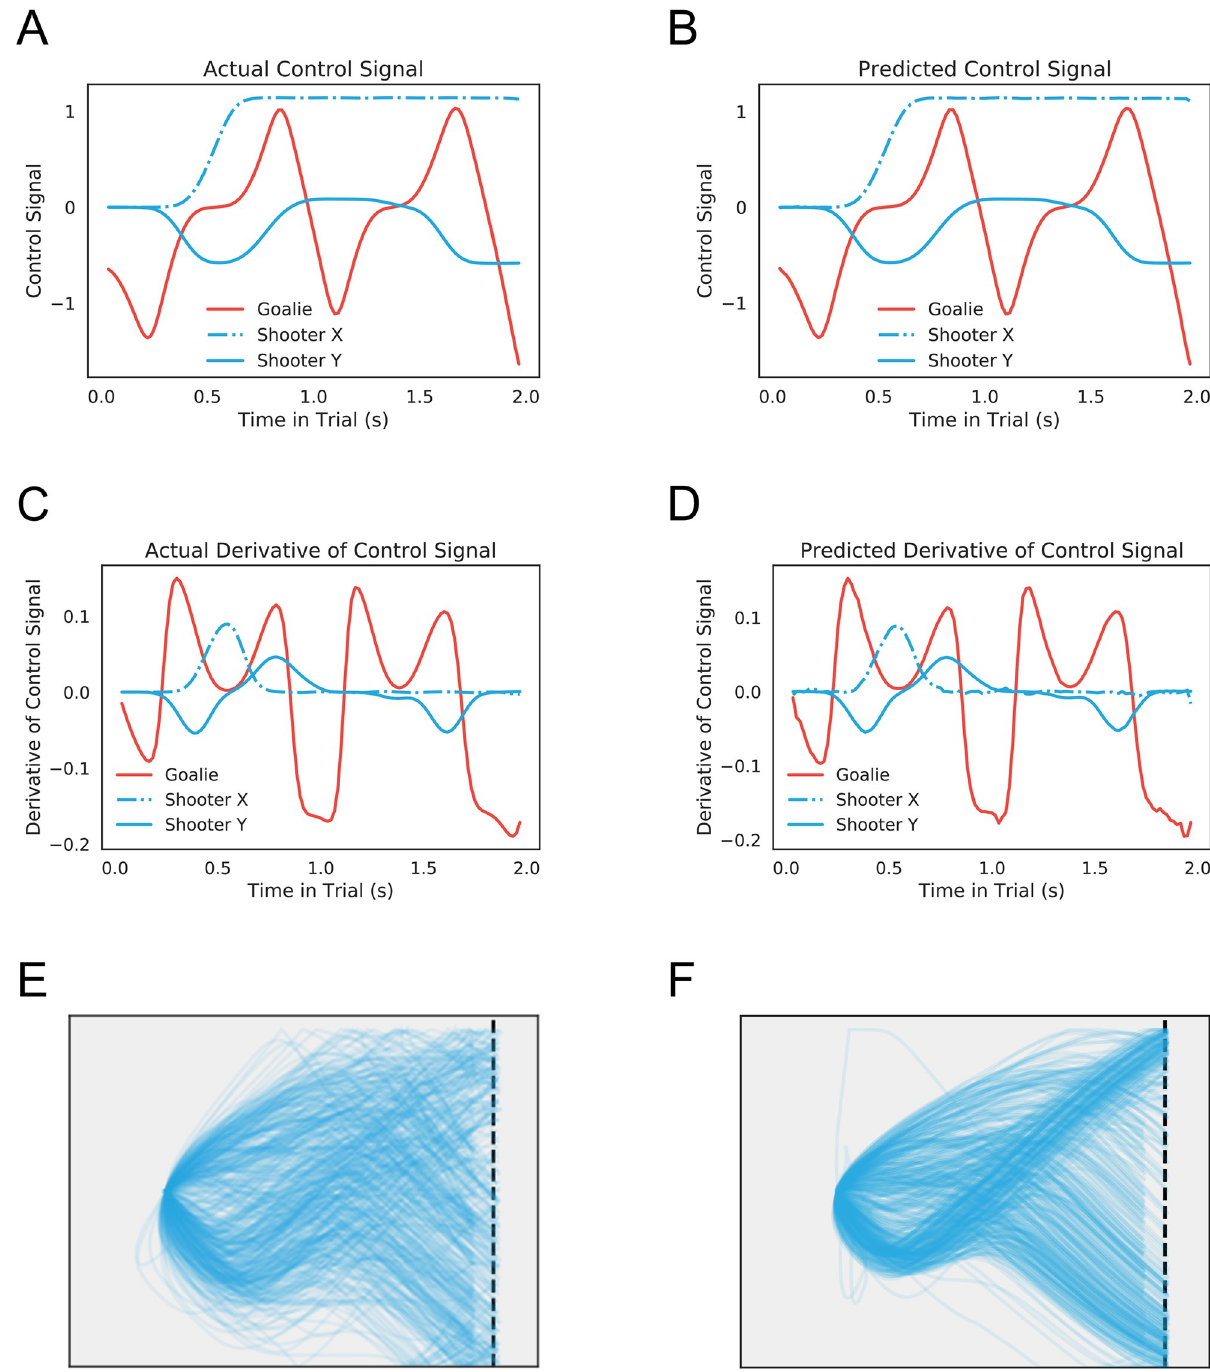
Fig 4. Model fits and generated data. A: Actual control signals for both coordinates of puck (blue) and bar (red) for a single trial in the holdout set. B: Model predictions for control signals at the next time step given real data up to the current time. The fitted model’s predictions control closely track the real data. C, D: Plots of actual control derivatives and model-predicted derivatives for the same trial. On this scale, deviations become more apparent, but the model still closely fits the data. In both cases, model fits reflect the accuracy of the posterior map, not necessarily the generative model. E: Real puck trajectories (n = 500) drawn from a model fit to the last ten sessions of the experiment (only trials that last less than 25 longer trials were included in training). F: Puck trajectories (n = 500) generated from the model (only trials that last less than 25 model has accurately captured the qualitative features of real